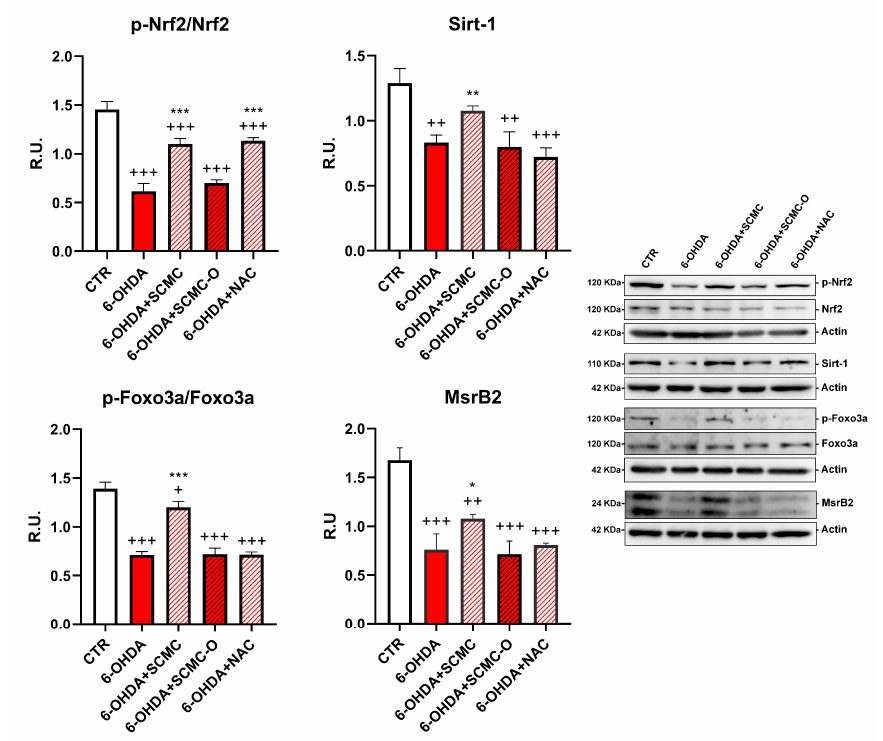
Figure 5. WB analyses p-Nrf2 and Sirt-1/Foxo3a/MsrB2 pathway. A representative figure is shown. Data are mean ± SD of three different experiments. *: p < 0.05; **: p < 0.005; ***: p < 0.0001; p < 0.005 vs. 6-OHDA; +: p < 0.05; ++: p < 0.005; +++: p < 0.0001 vs. CTR.